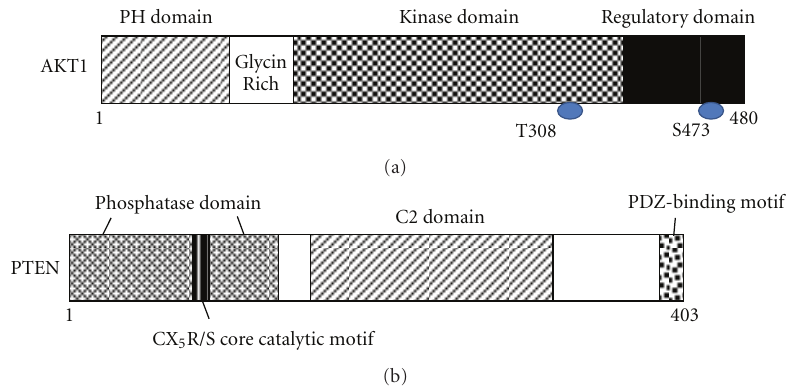
antagonizes PI3K activity [21]. PTEN gene, which